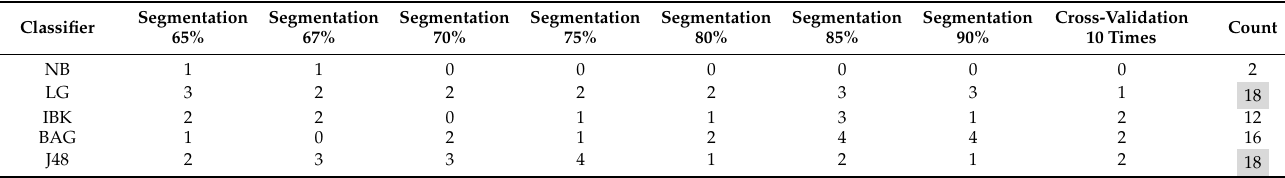
Table 21. The statistical results of best classifier for samples in the five ratio groups with feature selection from Tables 6, 8, 10, 12, and